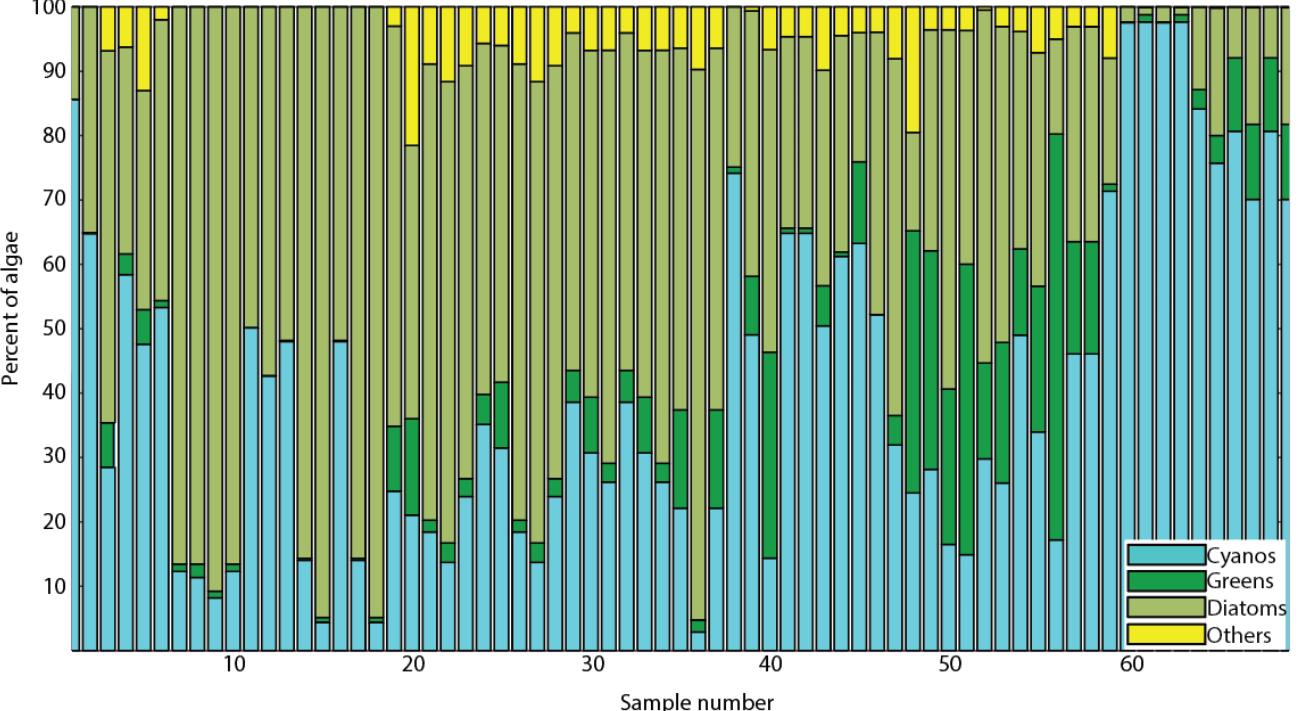
Figure 3. Cumulative percentage of each defined phytoplankton class. Each bar represents percent composition of in situ biovolume data for one of 69 samples that were available where at least one pixel in a 9 × 9 box around a sampling point exhibited a CI value greater than zero. Cyanobacteria are represented in blue, green algae in green, diatoms in tan, and unclassified (other) algae in yellow.